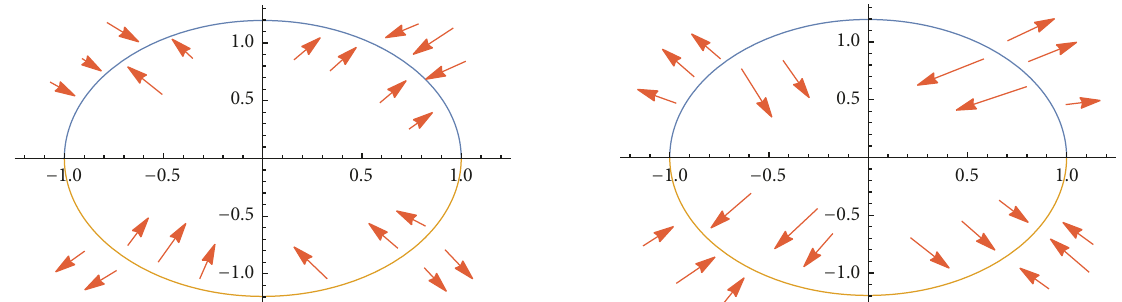
Figure 1: The half attracting conic when 𝜆 > 0, 𝜆 1 < 0 or 𝜆 < 0, 𝜆 1 >